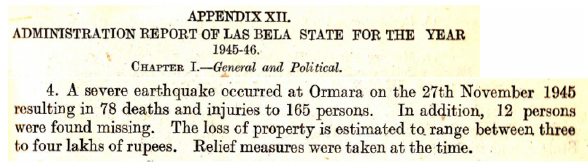
Figure 8. Excerpts of Baluchistan Agency Administration